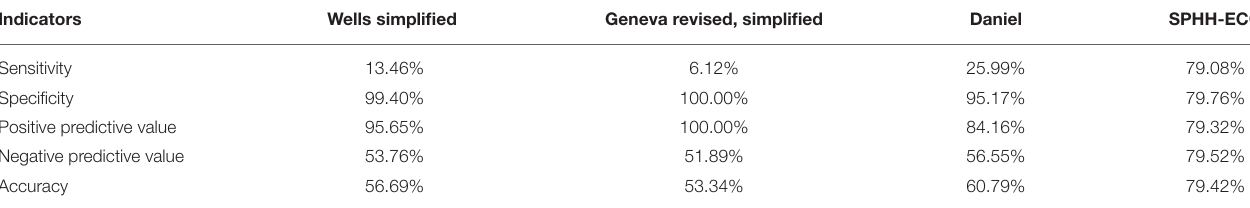
FIGURE 2 | The comparison of area under the receiver operating characteristic curve (AUC) of the SPPH-ECG model, Daniel-ECG score, the Wells score, and Geneva score.